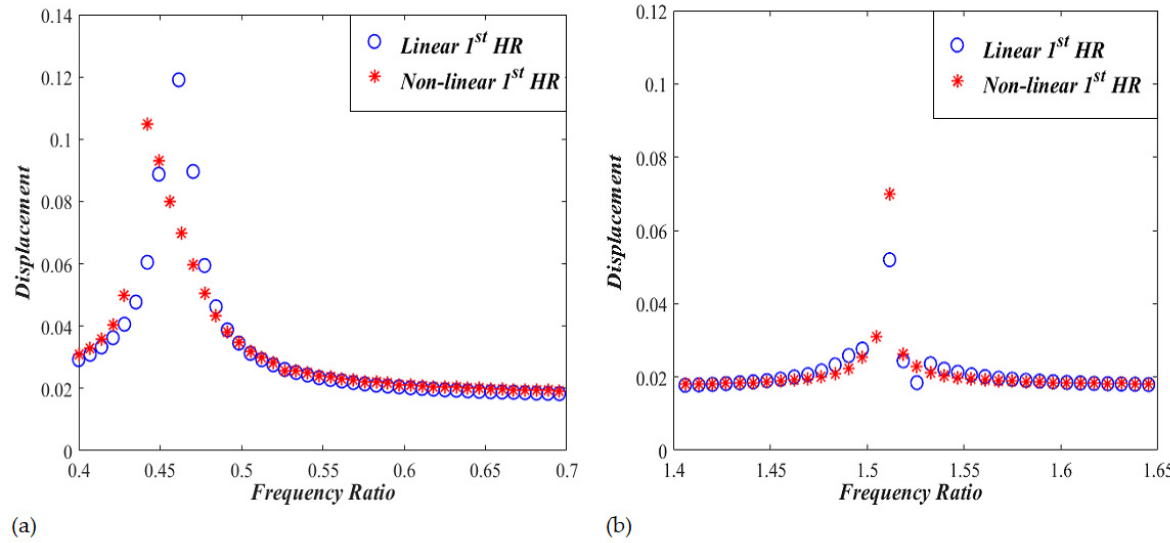
Figure 7. Frequency response curves for linear and non-linear nonlinear dual HRs (CASE II). ( a ) first resonant response, and ( b ) second resonant response.